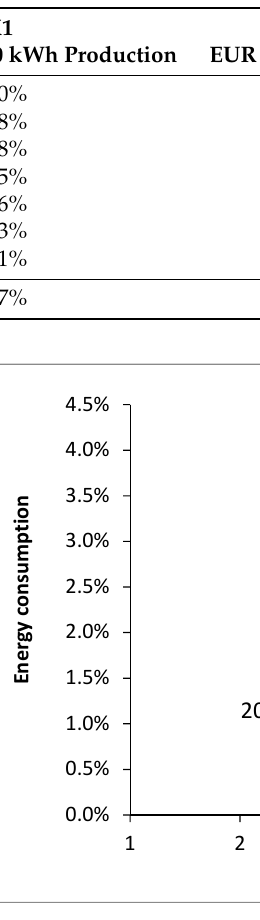
Figure 5. Percentage of the energy consumption of the plants in relation to the dilution ratio.